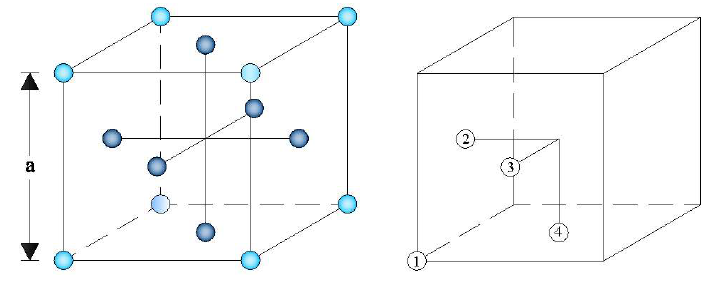
Figure 2. The fcc unit cell.